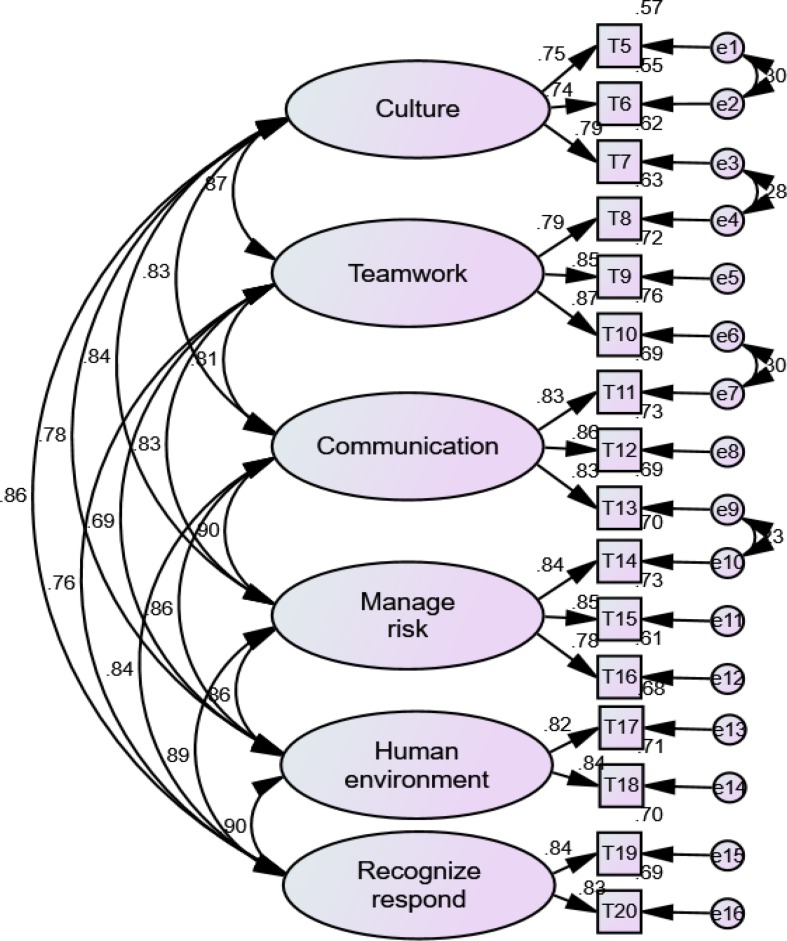
The factor structure of H-PEPSS-CV in clinical practice versionX2/df = 4.07 (p = 0.065), comparative fit index = 0.97, normed fit index = 0.96, Tucker-Lewis index = 0.97, and root-mean-square error of approximation = 0.065.